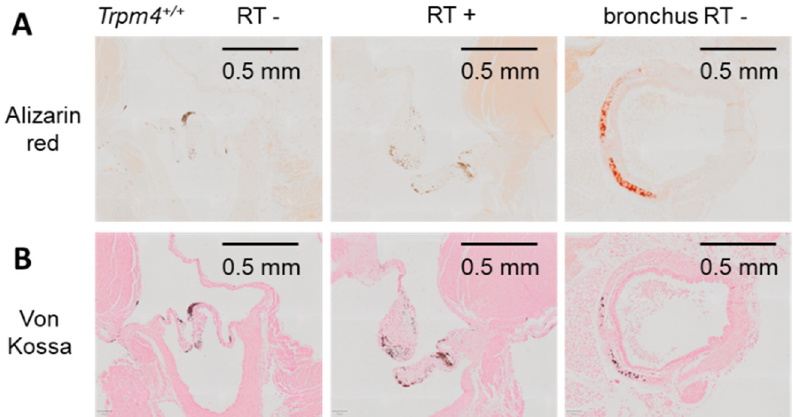
Figure 9. No valvular calcification induced by irradiation. Histological slices performed at 5 months post-treatment in the longitudinal axis (3 μ m thickness) of the aortic valve representative for Trpm4 +/+ mice after radiation treatment or not ( left and middle images ). The right images present a slice which includes a bronchus with cartilage as a control of calcified tissue. ( A ) Slices stained with alizarin red. Red labeling appears in the cartilage from the bronchus but no red staining was detectable on valvular cusps. Note that brown labeling is most likely attributable to melanocytes. ( B ) Slices of the same hearts as in A, stained with Von Kossa.